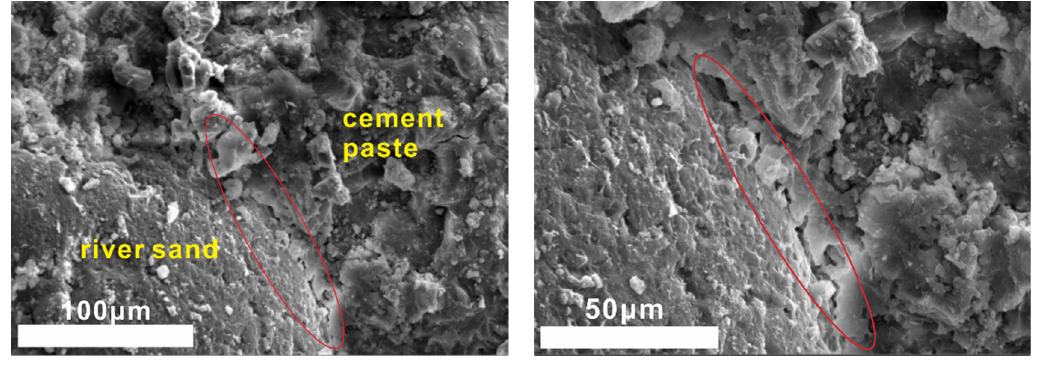
Figure 13. SEM images of samples hydrated for 28 days with river sand as the aggregate.